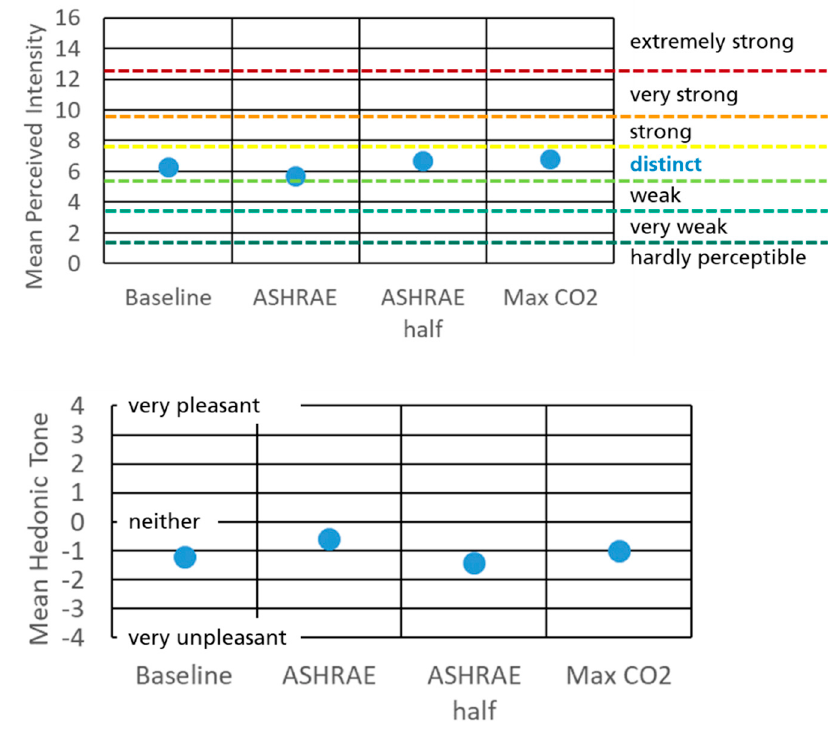
Figure 14. Assessment of air quality by trained odor panel.